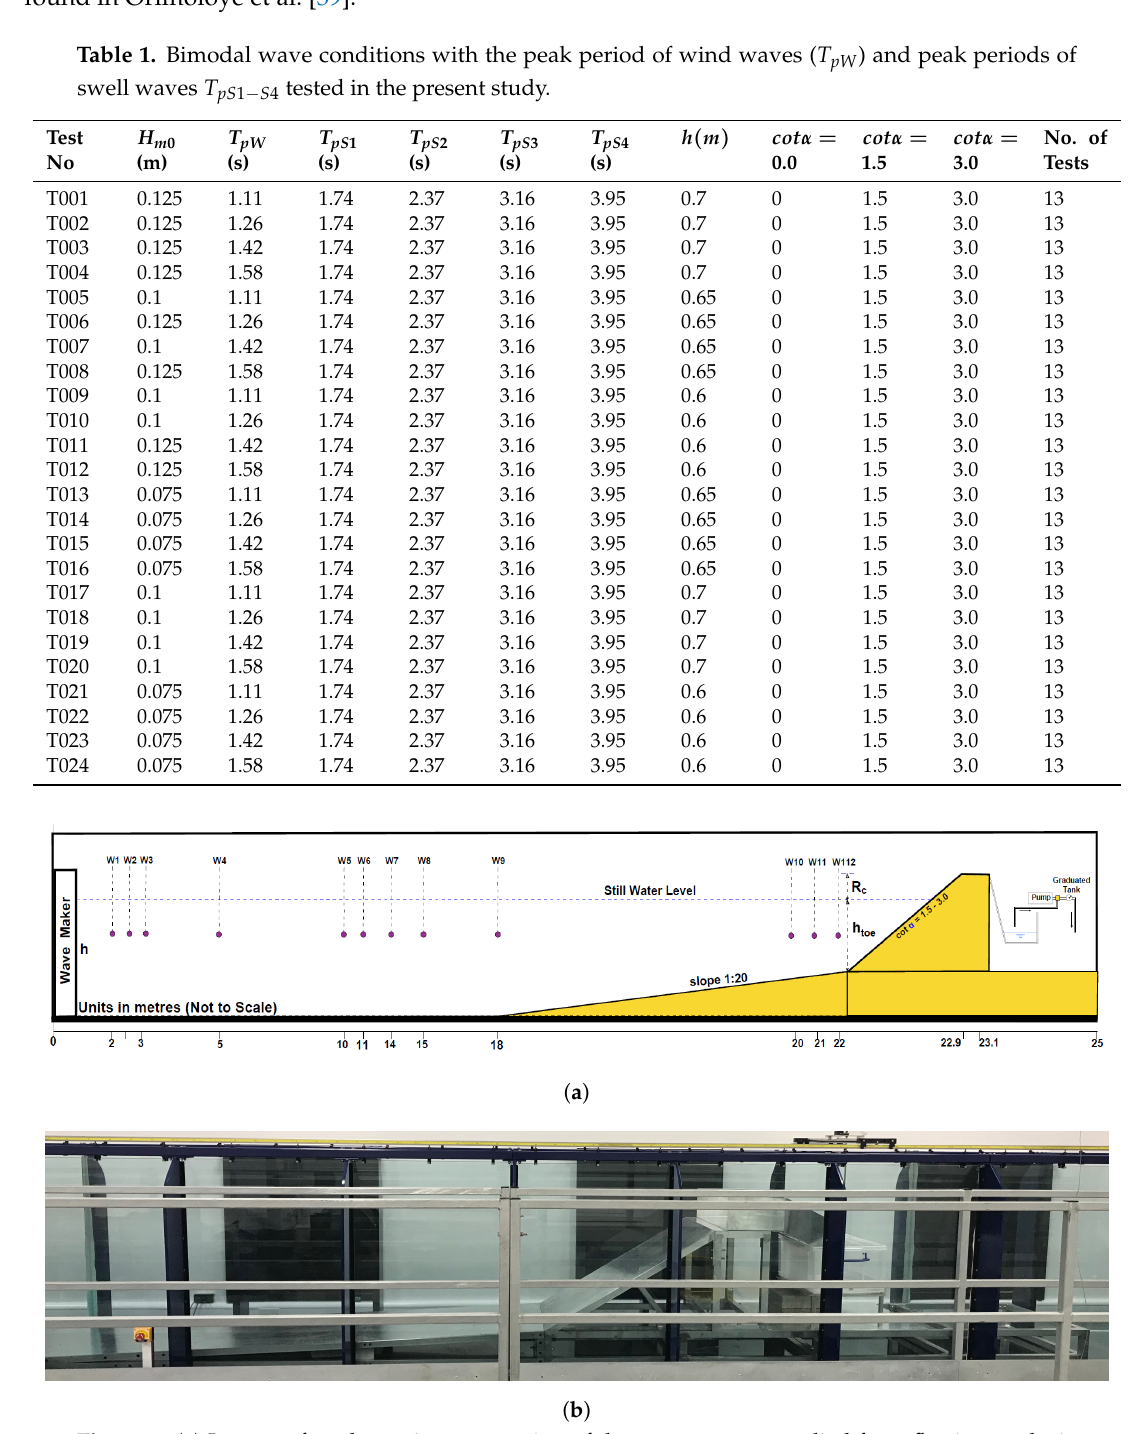
Figure 3. ( a ) Layout of a schematic cross-section of the wave gauges applied for reflection analysis. ( b ) Photograph of the constructed